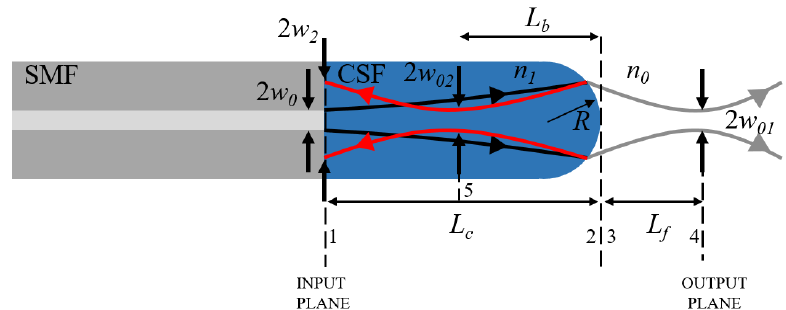
Figure 1. Schematic of a lensed optical fiber (LOF) structure. L c : length of coreless silica fiber (CSF), L f : working distance or focal length, L b : focal length of reflected beam, R : radius of lens curvature, w 0 : half of the mode-field diameter (MFD) of single-mode fiber (SMF), w : beam spot at each interesting position, n : refractive index of the medium.